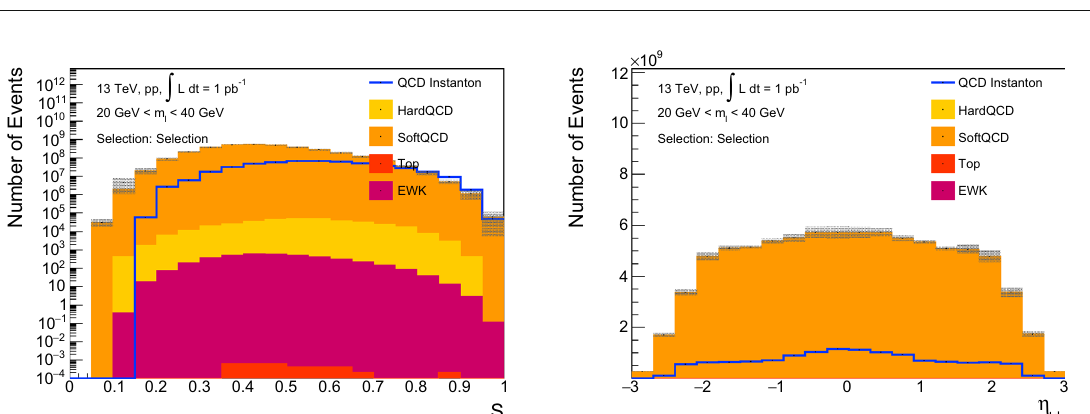
Fig. 10 Predicteddistributionsoftheeventsphericity(left)andpseudo rapidity, η , of reconstructed charged particles (right) for various pro- cesses,weightedbytheirpredictedcrosssectionsforanintegratedlumi- (cid:8) nosity of L = 1pb − 1 after the nominal selection. The invariant mass